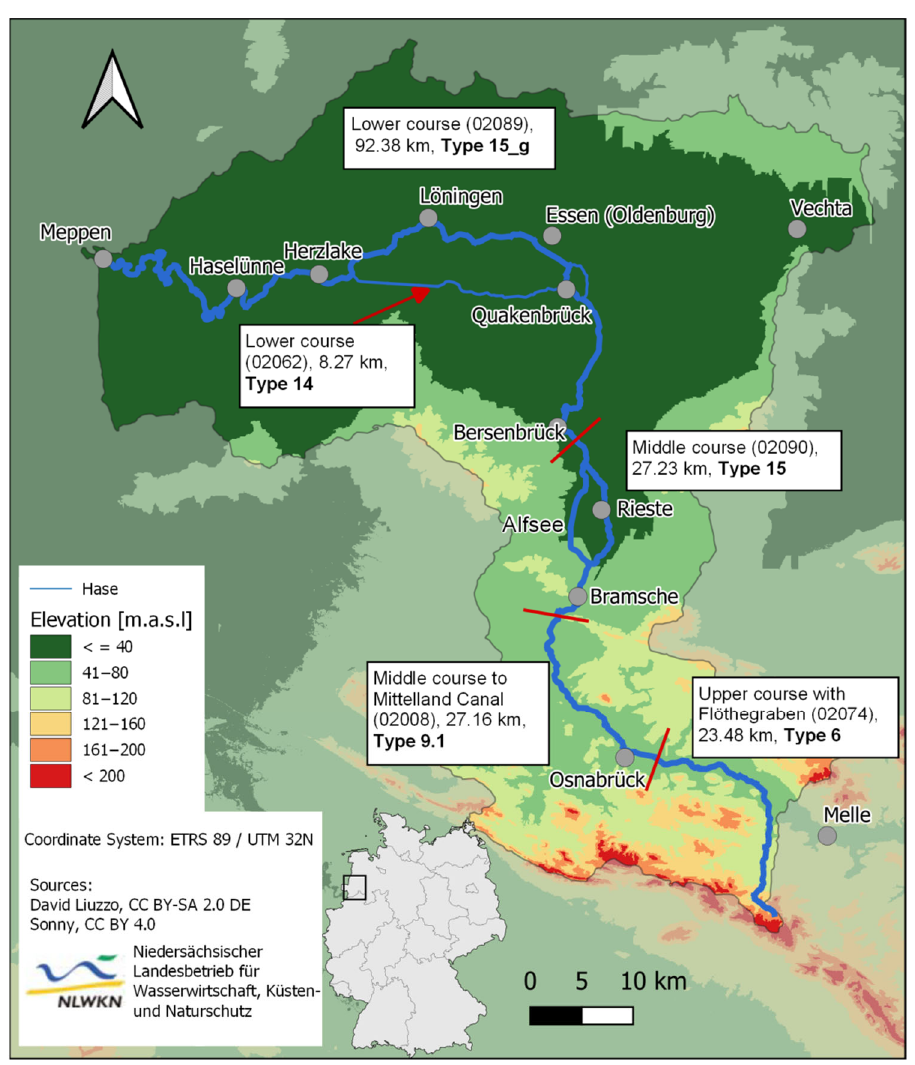
Figure 1. Relief map of the Hase catchment with the Hase watercourse, reference river type, number of NLWKN water body in parenthesis and length of the river section (data sources: [33–36] ).